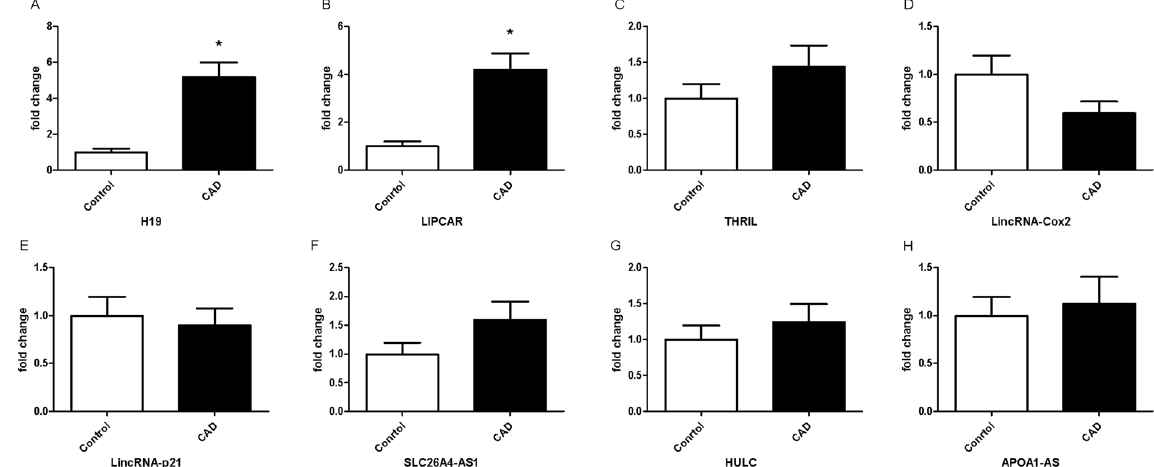
Figure 1. Plasma levels of lncRNAs in patients with CAD and controls. Plasma levels of H19 ( A ) and LIPCAR ( B ) are increased in patients with CAD compared with controls. No significant difference was observed in the plasma levels of THRIL ( C ), LincRNA-Cox2 ( D ), LincRNA-p21 ( E ), SLC26A4-AS1 (F), HULC ( G ), and APOA1-AS ( H ) between patients with CAD and controls. CAD, coronary artery disease; * P < 0.05.